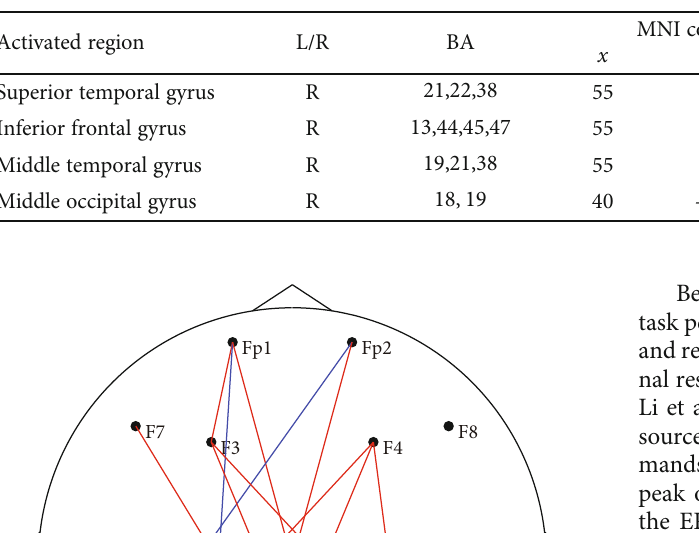
Table 3: The details of the stronger activity for N2 in HCs.